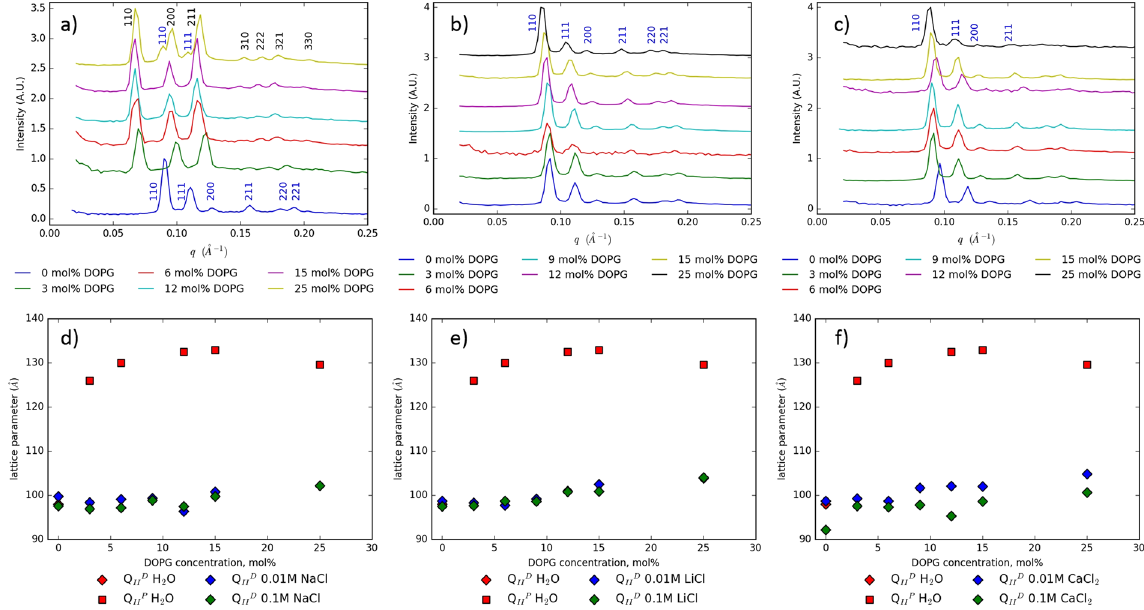
Figure 2. The effect of changing the hydrating salt cation in lipid systems of MO and DOPG. Bragg peaks in figs ( a–c ) have been indexed according to the Miller indicies of the reflection place, with Blue labels indicating a Q IID plane, and Black Q IIP one. ( a ) 1D radially integrated SAXS pattern of increasing DOPG concentration measured in water; ( b ) increasing DOPG concentration measured in 0.1 M LiCl; ( c ) increasing DOPG concentration measured in 0.1 M CaCl 2 . The effect of two concentrations - compared to water - of ( d ) NaCl on the phase and lattice parameter of a MO:DOPG cubic phase; ( e ) LiCl on the phase and lattice parameter of a MO:DOPG cubic phase; ( f ) CaCl 2 on the phase and lattice parameter of a MO: DOPG cubic phase. Further scattering 1D SAXS patterns of the NaCl and LiCl systems are in the Supplementary Information, Figures